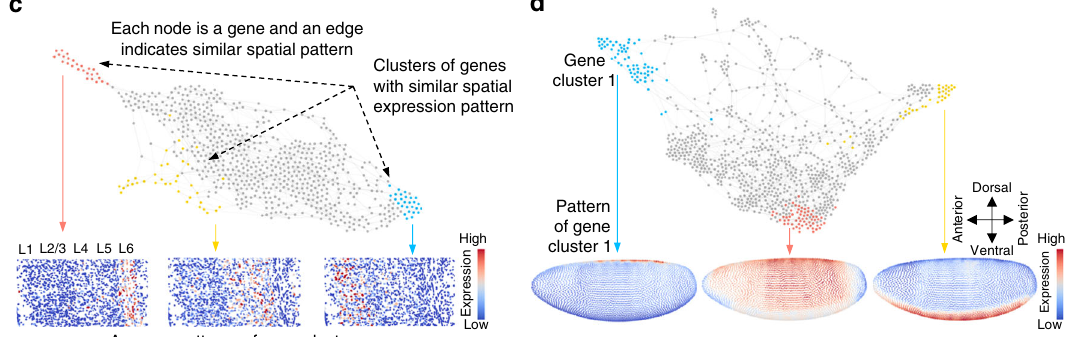
Fig. 3 Metric spaces and spatial gene atlases for scRNA-seq data. a A low-dimensional spatial visualization (UMAP) of mouse visual cortex scRNA-seq data (ref. 37 ) using the cell – cell distance inferred by SpaOTsc with the spatial data (ref. 38 ). The cell labels are taken from ref. 37 . b Similar to (a) but for Drosophila embryo data (ref. 10 ). c, d The gene spatial atlases for mouse visual cortex data ( c ) and Drosophila embryo data ( d ) consisted of collections of highly variable genes where nodes represent genes and edges indicate similarity in spatial